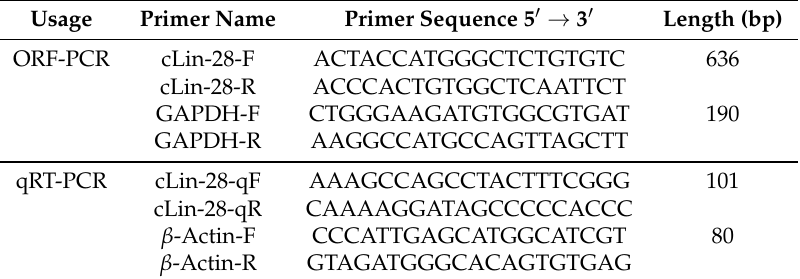
Figure 2. cLin-28 mRNA expression levels in different tissues. The results are expressed relative to an endogenous control, β -actin. Table 1. List of primers used for the amplification and sequencing